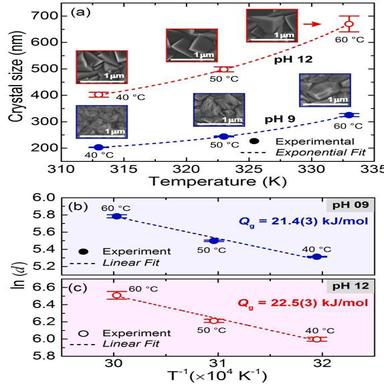
(a) Crystal size (d) of the samples Cu2O thin films deposited at pH 9 and pH 12 as a function of the bath temperature. The crystal size corresponds to the mean diameter obtained after a statistical analysis performed via a log-normal fit of the size distribution histograms. The data was fitted via an exponential function to highlight the exponential character of the crystal growth. The inset presents correspondent representative FE-SEM micrographs showing the evolution of the size of the cryst